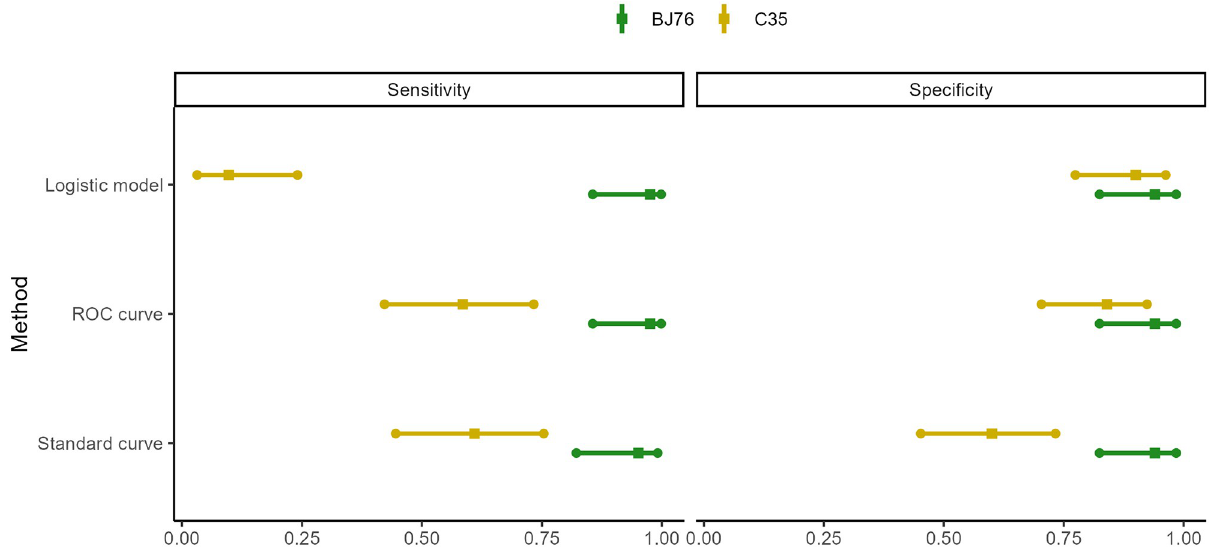
Fig 4. A forest plot comparing sensitivity and specificity for the different models. Sensitivity (left) and specificity (right) are plotted with 95% confidence intervals. Classifications using the standard curve cutoffs for BJ76 were made using the average of cutoffs for each run. BJ76 sets were run in duplicate and OD 450 values were averaged (original individual values are in Table 1). BJ76 performs better than CS35 in all cases.